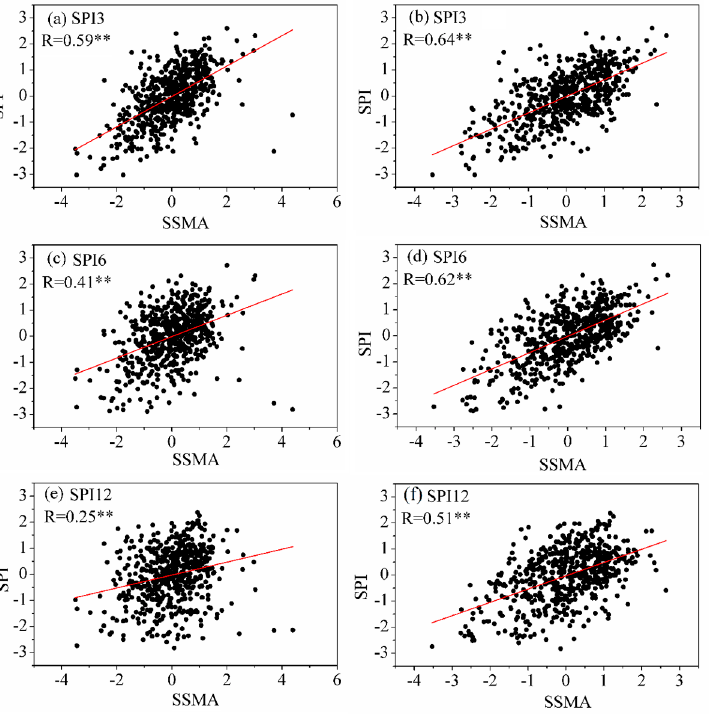
Figure 6. Correlation between the SPI at different time scales and SSMA from different layers, ( a , c , e ) for 0 − 10 cm and ( b , d , f ) for 0 − 100 cm. (** significant at the 0.01